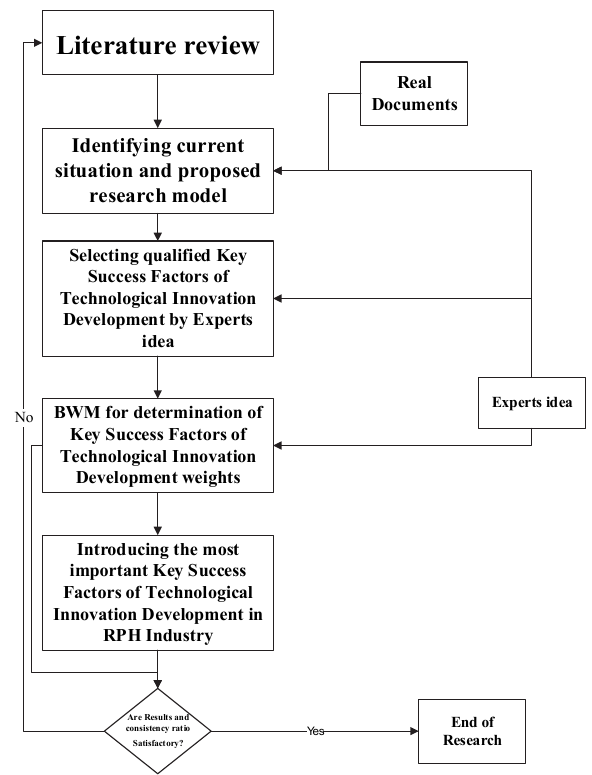
Fig. 1. Flowchart of the proposed MCDM